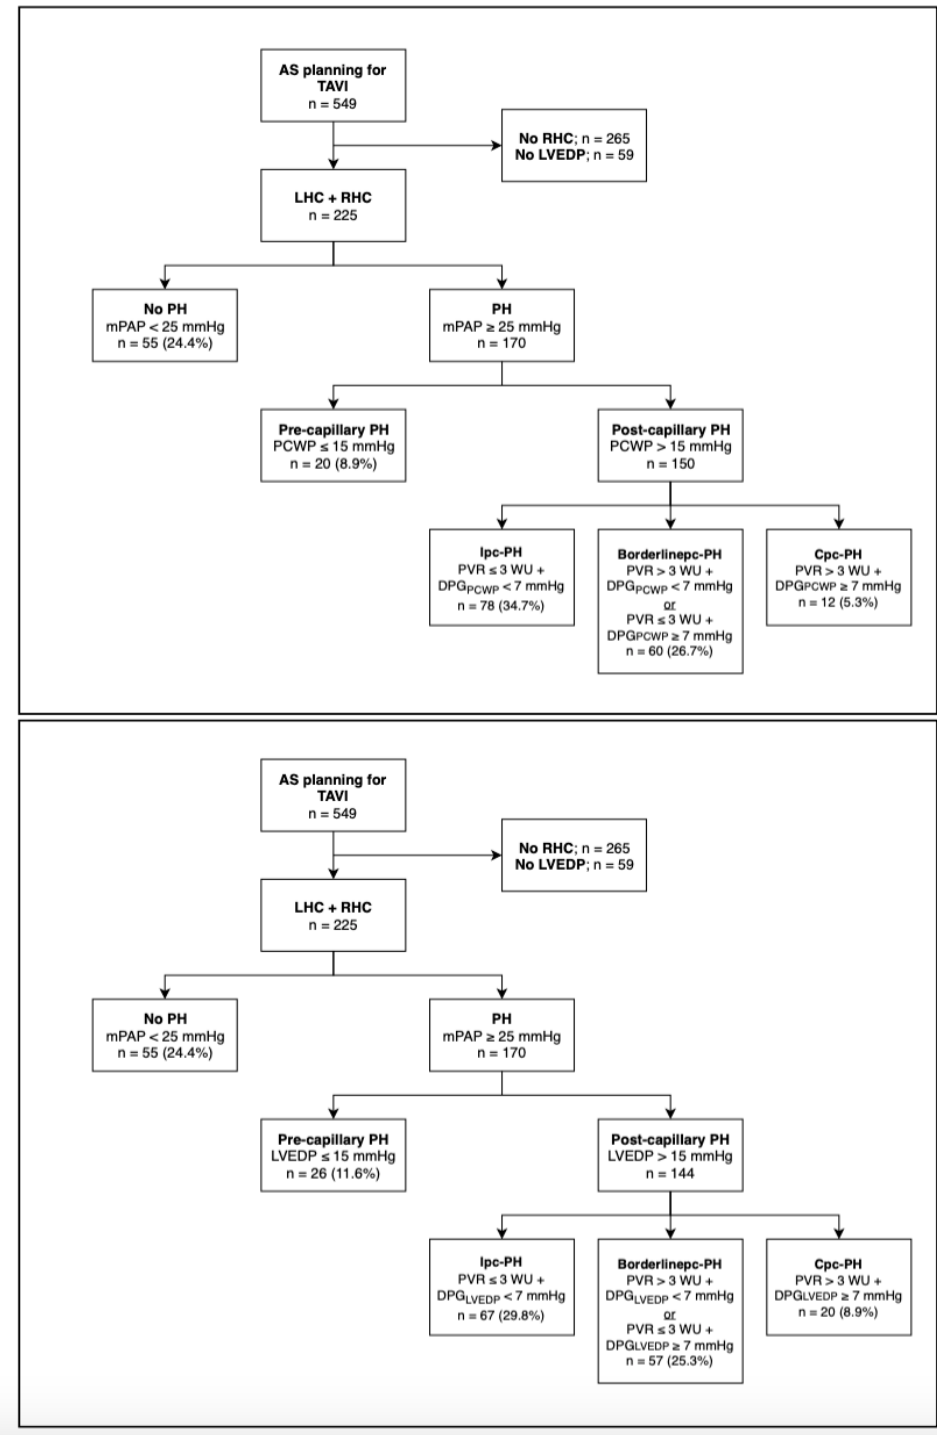
Figure 1. Patient disposition in study cohort. AS: aortic stenosis; TAVI: transcatheter aortic valve implantation; LHC: left heart catheterization; RHC: right heart catheterization; LVEDP: left ventricular end-diastolic pressure; PH: pulmonary hypertension; mPAP: mean pulmonary arterial pressure; PCWP: pulmonary capillary wedge pressure; Ipc-PH: isolated post-capillary pulmonary hypertension; Borderlinepc-PH: borderline post-capillary pulmonary hypertension; Cpc-PH: combined post- and pre-capillary pulmonary hypertension; PVR: pulmonary vascular resistance; DPG: right diastolic pressure gradient.